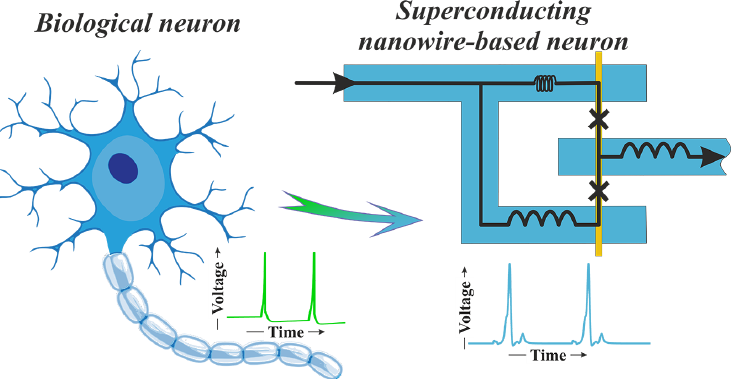
Figure 1. Sketch of a biological neuron and its artificial counterpart made of a superconducting material with a normal metal